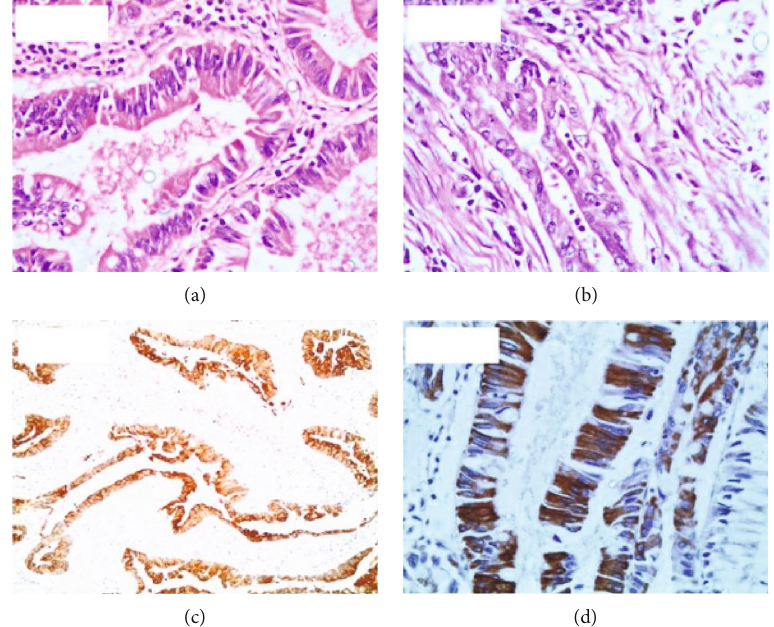
Figure 3: (a) Tall columnar cells in mixed-type carcinoma (hematoxylin-eosin, 400x). (b) Cuboidal cells in mixed-type carcinoma (hematoxylin-eosin, 400x). (c) CK7 positivity in mixed-type carcinoma (immunohistochemistry, 100x). (d) Ck20 positivity in mixed-type carcinoma (immunohistochemistry, 400x).